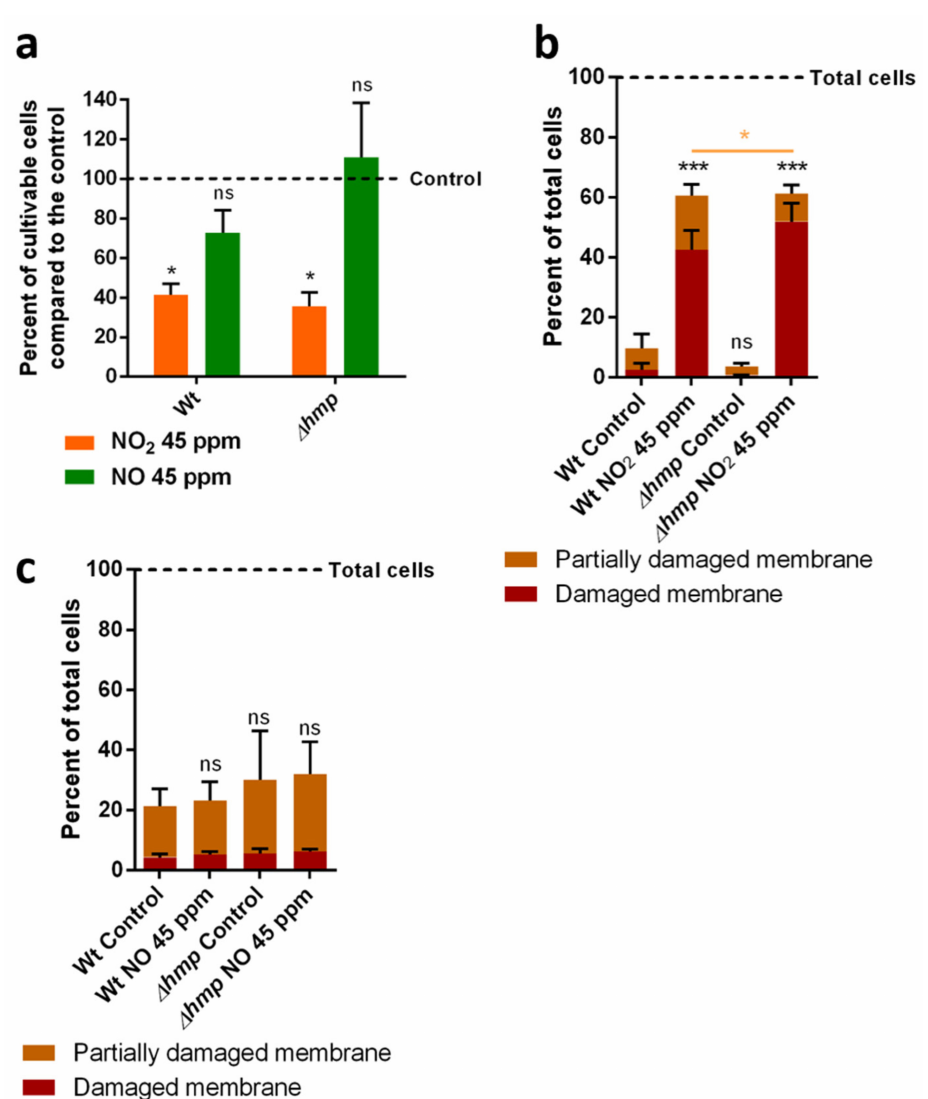
Figure 2. Impact of hmp deletion on the physiological modifications of P. fluorescens MFAF76a after exposure to NO 2 or NO. ( a ) Cultivability of bacteria after exposure to NO 2 or NO compared to cells exposed to synthetic air. ( b ) Membrane integrity of P. fluorescens MFAF76a and MFAF76a ∆ hmp assessed by the Live/Dead BacLight kit (L-7012, ThermoFisher) flow cytometry assays after exposure to 45 ppm of NO 2 . ( c ) Membrane integrity of P. fluorescens MFAF76a and MFAF76a ∆ hmp assessed by live-dead flow cytometry assays after exposure to 45 ppm of NO. Graphs represent means ± SEM. ns = p > 0.05; * = p < 0.05; *** = p < 0.001, N ≥ 3. In cytometry experiments, black stars represent the significance of overall cell membrane alterations, while orange stars represent the difference between partially damaged membranes between the wild-type and the ∆ hmp